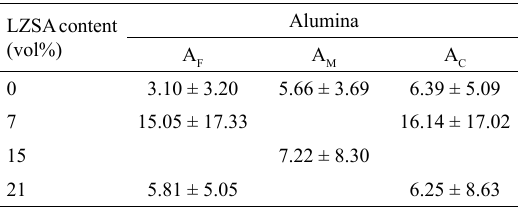
Figure 3. SEM observations of alumina A = 0.75) and composites A (1,600 ºC/40 min, d Table 4. Average grain size of alumina in pure alumina and composites.